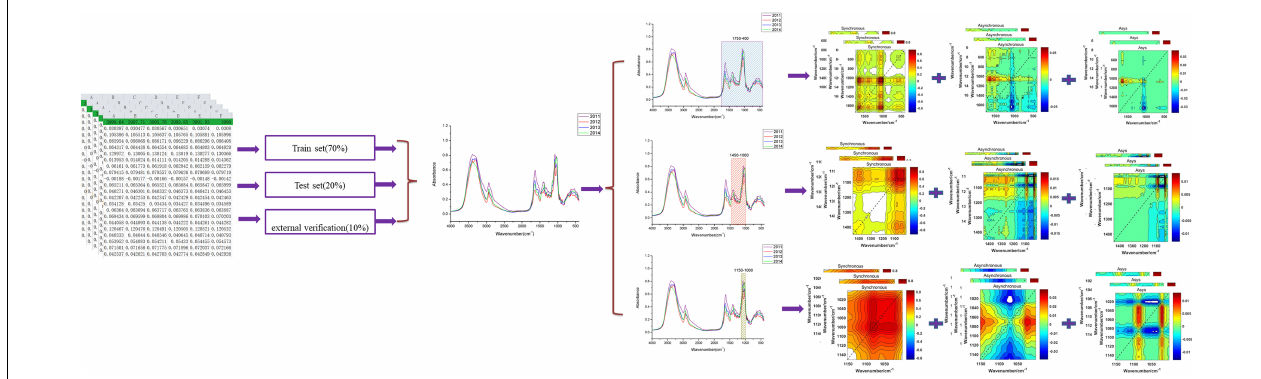
FIGURE 1 | The generation processes of 2DCOS and